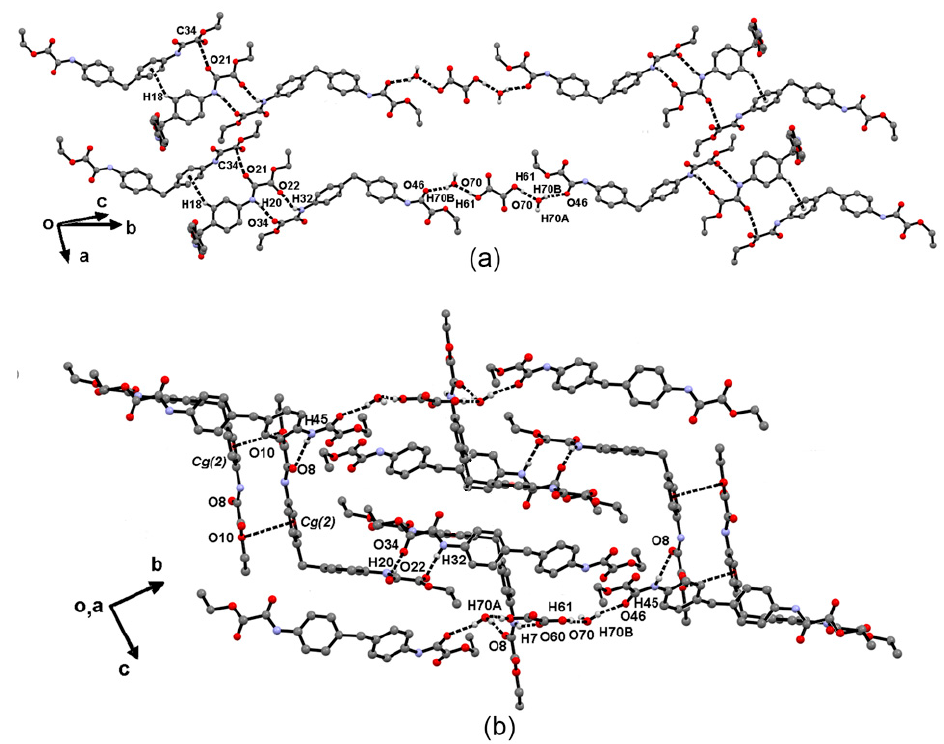
Figure 6. ( a ) 1D supramolecular tape of 1 2 •½(C 2 H 2 O 4 )•H 2 O involving N-H···O and O-H···O hydrogen bonds, and ( b ) C-H··· π and C=O···C=O interactions.